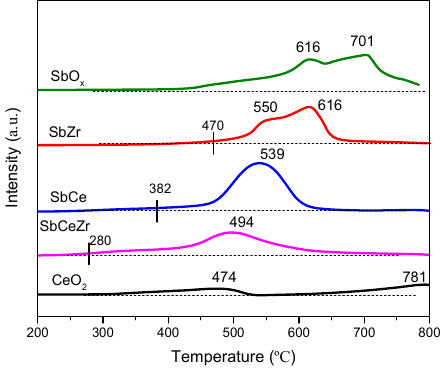
Figure 5. H 2 -TPR profiles of the catalysts.